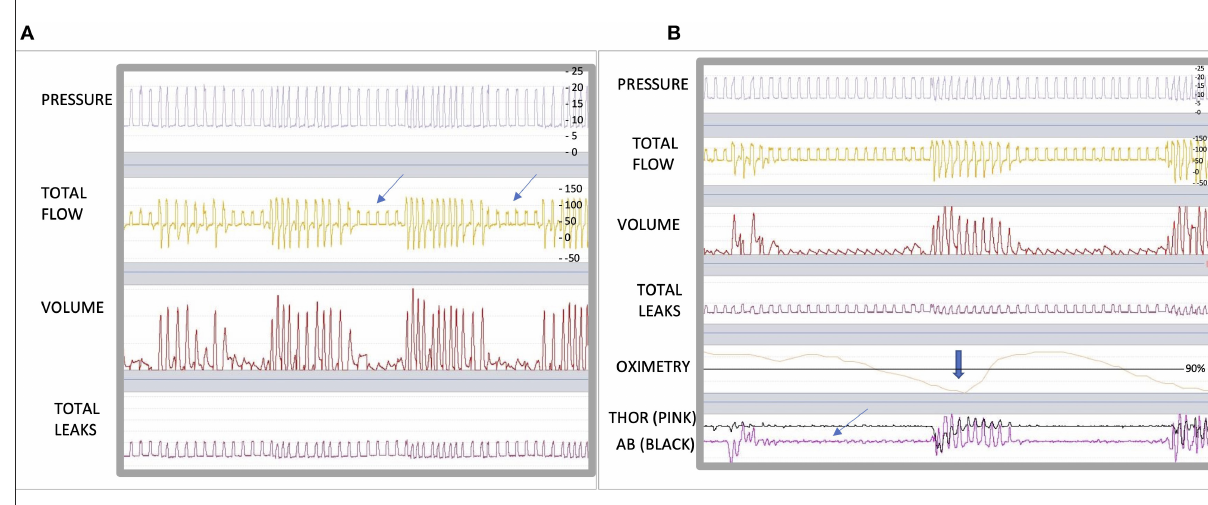
FIGURE2 (A) shows a 5min epoc in Breas TM PC software (Breas Medical, Mölnlycke, Sweden). The arrows highlights obstructive events. (B) shows a 5min epoc in Breas TM PC software with the addition of SpO2 probe and abdominal [AB (black)] and thoracic [THOR (pink)] belts. The bold arrow shows important desaturation and the thin arrow shows the absence of movement of belts.